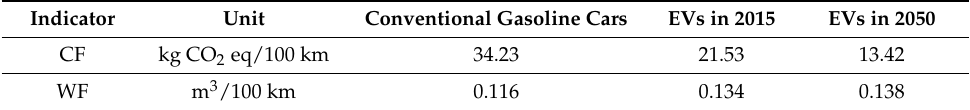
Table 4. A comparative analysis of carbon and water footprint of EVs and conventional gasoline